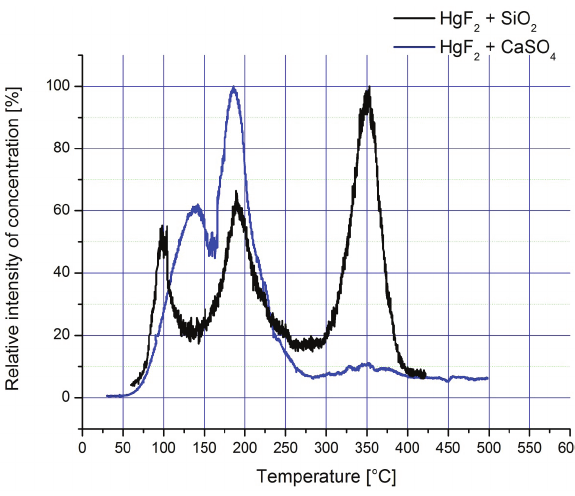
on ceramic boat, purged with air. 2